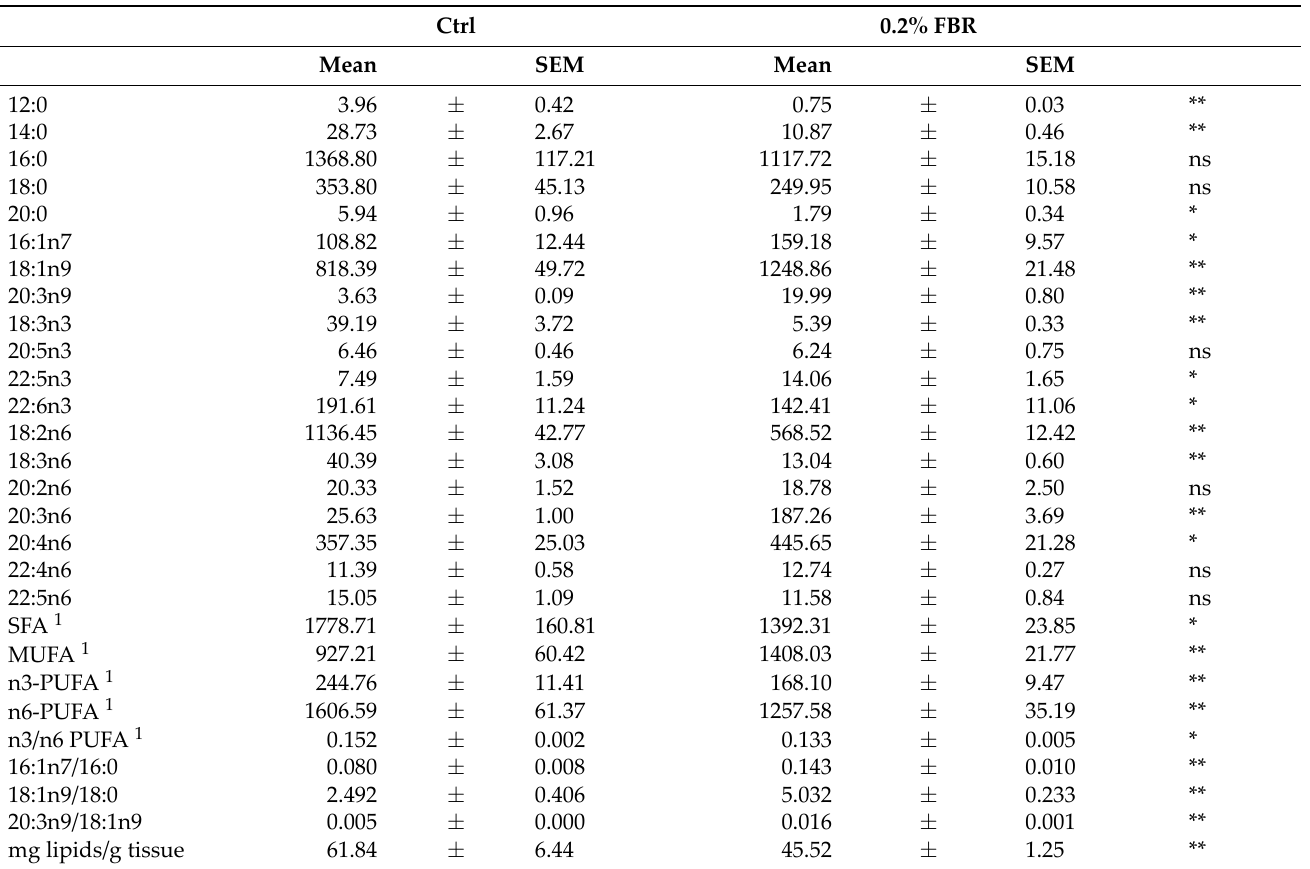
Table 1. Main fatty acids (FA) in liver of mice fed a control diet (Ctrl) or a 0.2% fenofibrate-supple- mented diet (0.2% FBR). Data are expressed as nmoles/mg of lipids and represent the mean ± SEM